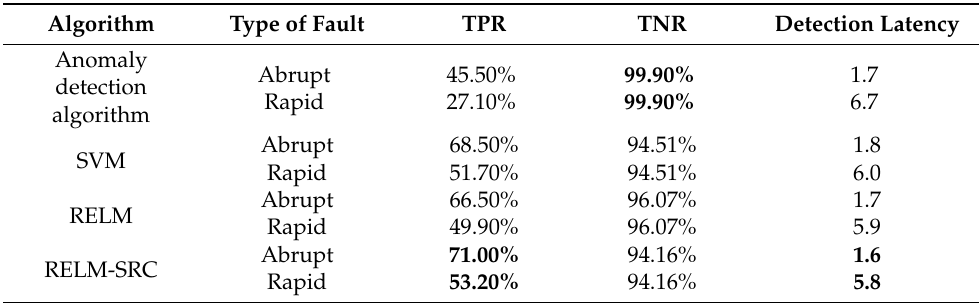
Table 9. Metrics for self-generated and ProDiMES cruise testing datasets averaged for abrupt and rapid faults (Stage 2, comparison with